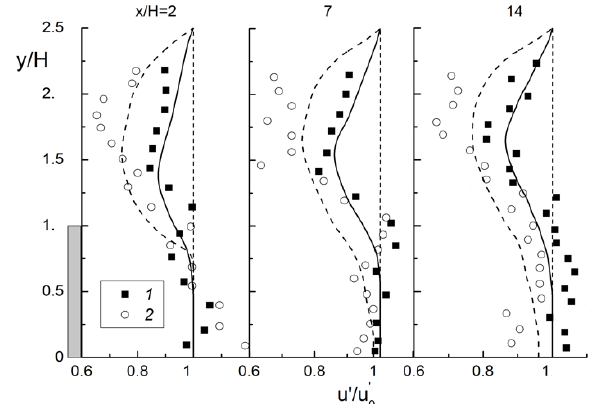
Figure 11. Turbulence modification ratio of the two-phase solid particle-laden flow to the single- phase flow u (cid:48) / u (cid:48) longitudinal fluctuating gas-phase velocities. Symbols are the results of experiments of [7] for glass particles, lines are the author’s simulations. d P = 150 µ m, ER = 1.67. 1: M P = 0.2; 2: